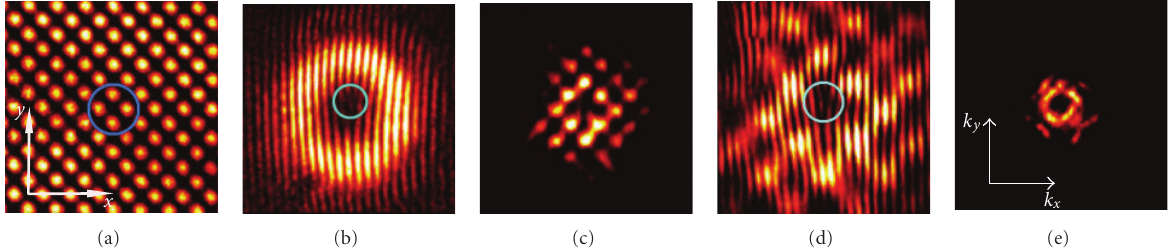
Figure 4: Experimental observation of an extended m = 2 gap vortex soliton in photonic lattices with self-defocusing nonlinearity. (a) lattice beam, where the circle shows the location of the input vortex, (b) the interferogram of the input vortex with a tilted plane wave to show the phase singularity, (c) self-trapped vortex pattern, (d) the zoom-in interferogram of (c) with a tilted plane wave, and (e) the Fourier-space spectrum of the m = 2 vortex soliton. The circles in (b) and (d) show the position of the phase singularity.